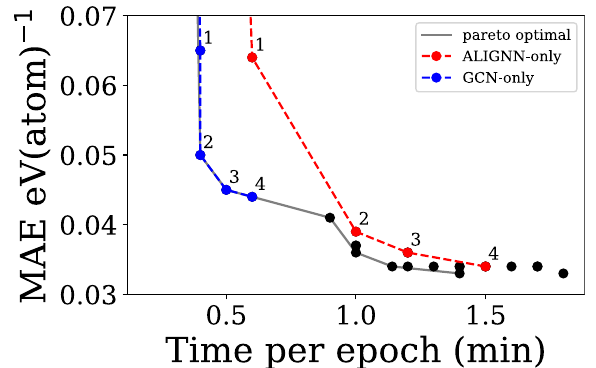
Fig. 3 ALIGNN accuracy-cost ablation study on JARVIS-DFT formation energy target. The red and blue markers represent the number of layers in GCN-only and ALIGNN-only models.